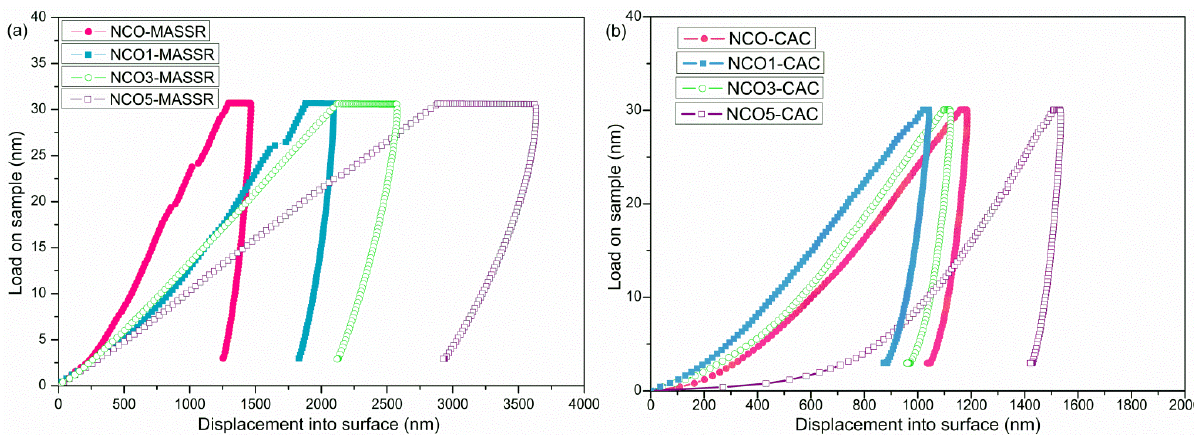
Figure 9. Load ‐ displacement curves obtained during nanoindentation test of ( a ) MASSR and ( b ) CAC ceramics.